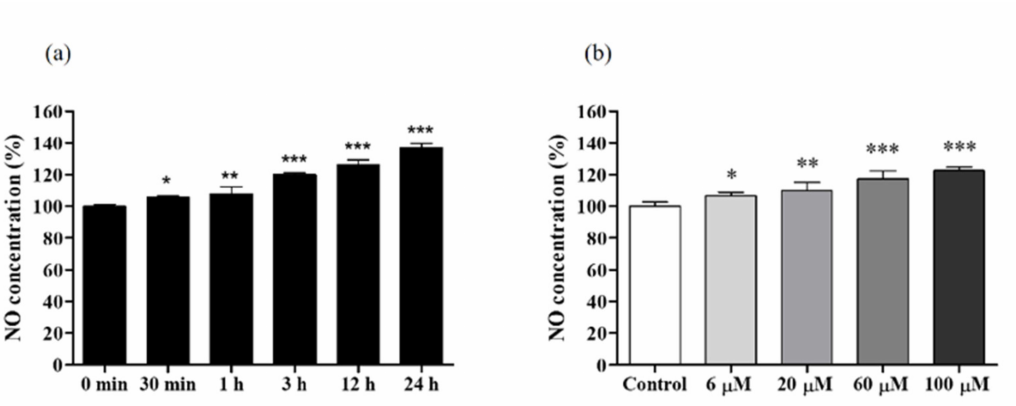
Figure 2. NO production in EA.hy926 cells treated with 60 µ M of diphlorethohydroxycarmalol (DPHC). ( a ) Levels of time-dependent NO production in EA.hy926 cells treated with 60 µ M of DPHC. ( b ) NO production in EA.hy926 cells induced by different concentrations of DPHC. Experiments were performed in triplicates. Each column and bar represent the mean ± standard deviation (S.D.). * p < 0.05, ** p < 0.01. *** p < 0.001, significant difference compared to the control